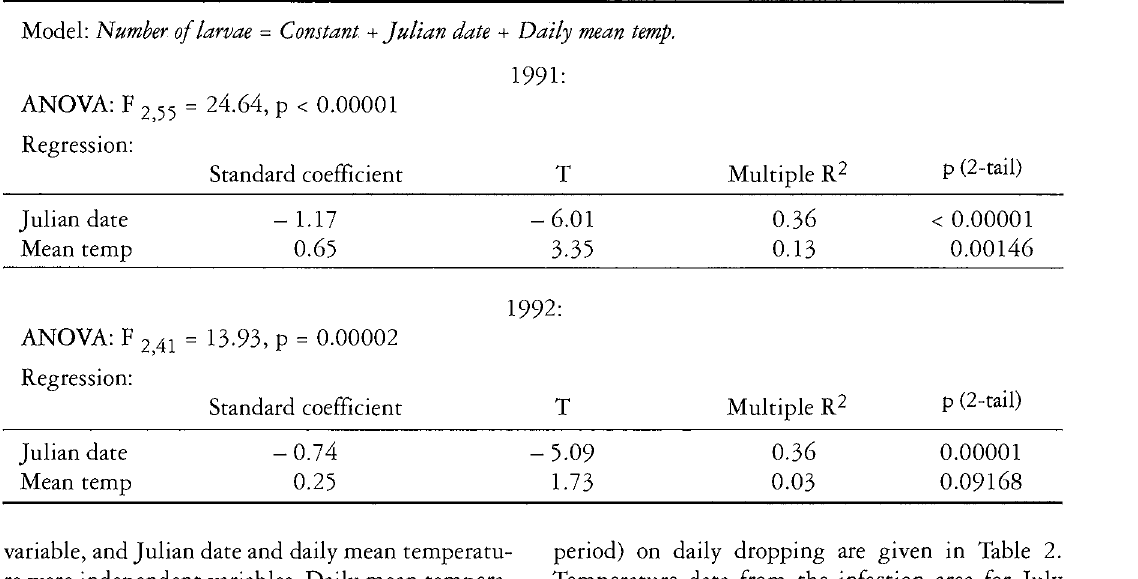
Table 2. Results from multiple regression of the influence of Julian date and mean temperature upon departure of H. tarandi larvae from host in 1991 and